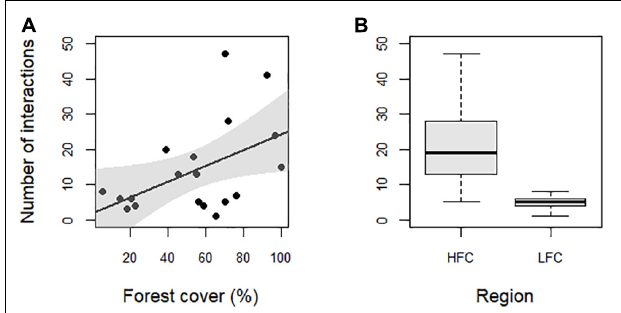
FIGURE 3 | Relationship between the number of interactions in bird-plant networks and predictors variables. (A) The relationship between forest cover and the number of interactions. (B) The total number of interactions observed in high forest cover (HFC) and low forest cover (LFC)